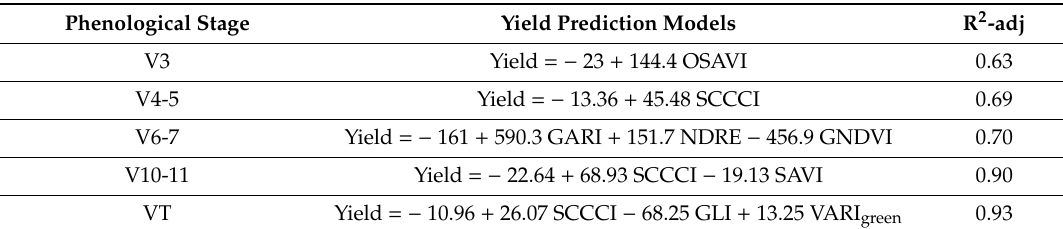
Table 2. Regression models and performance for each model to predict yield at different phenological stages.